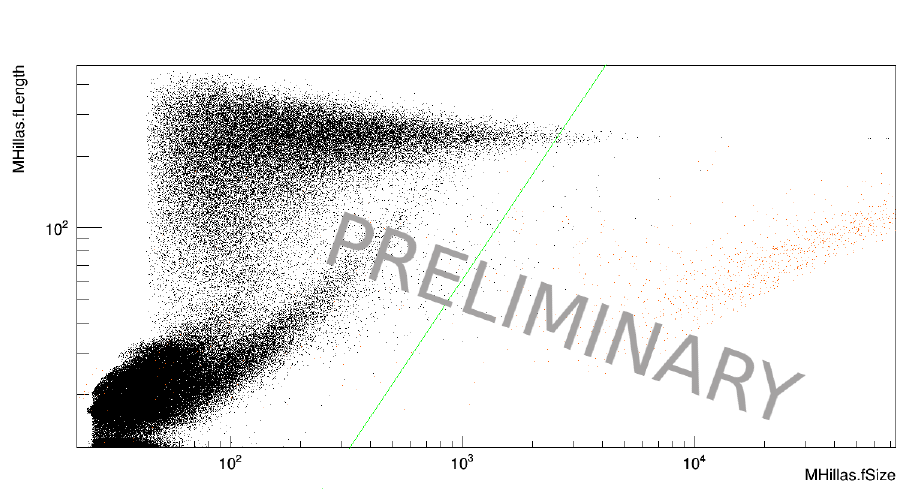
Figure 1. New selection cut (green line) on a larger sample of data ( 40 hours), obtained using a Fisher Discrimi- nant analysis. Black points are the measured events (background + signal), orange the simulated signal. Survived events from the present cut will have to pass a further selection step which is shown in